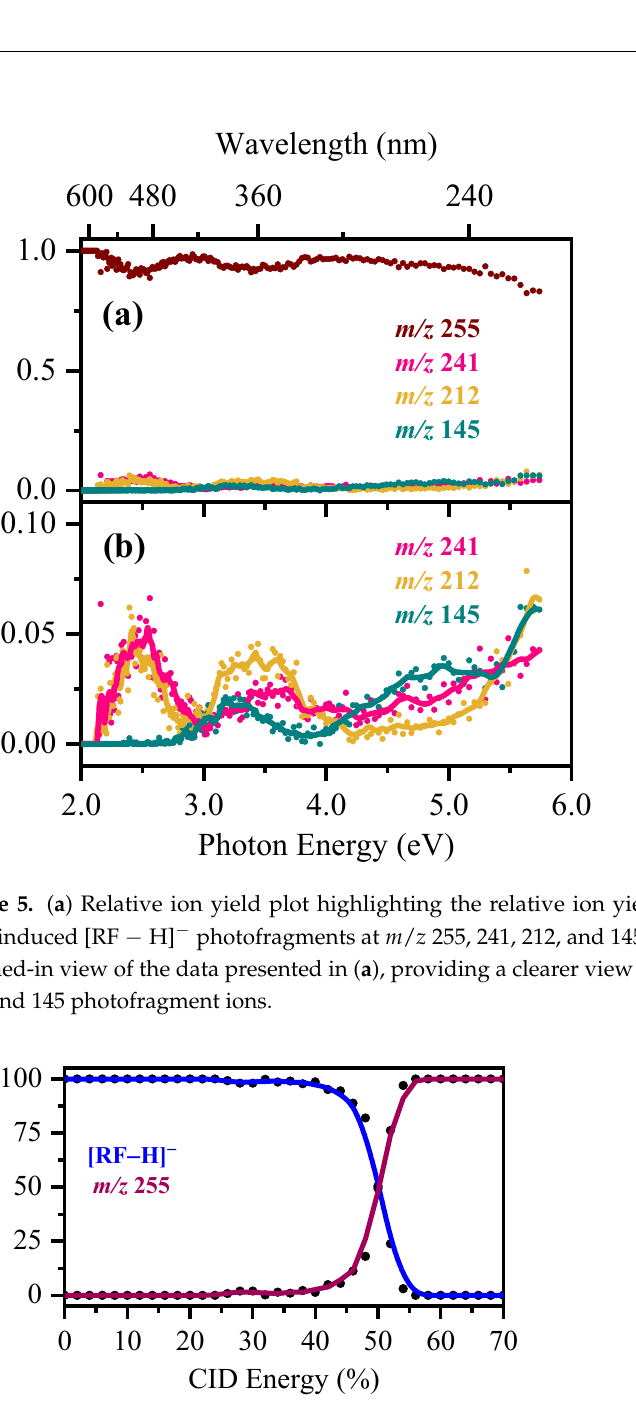
Figure 6. Low-energy collision-induced dissociation (CID) fragmentation decay curve for [RF − H] − ( m / z 375) upon CID between 0% and 70% CID energy. The curved lines included with the data points are a three-point adjacent average of such data points.